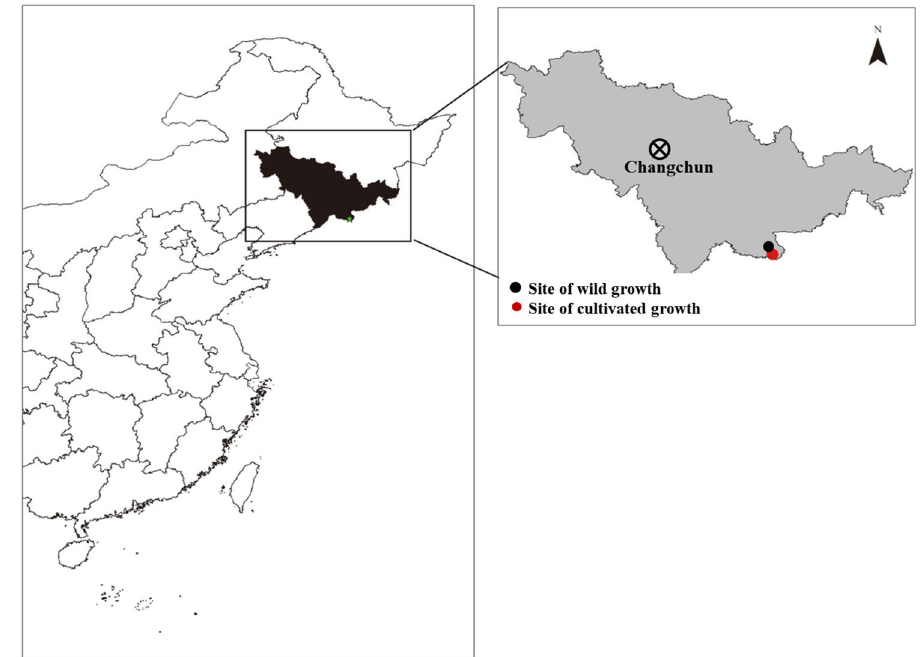
Figure 7. Location of the experimental sites. The black and red dots represent the sites where growled in cultivated and wild